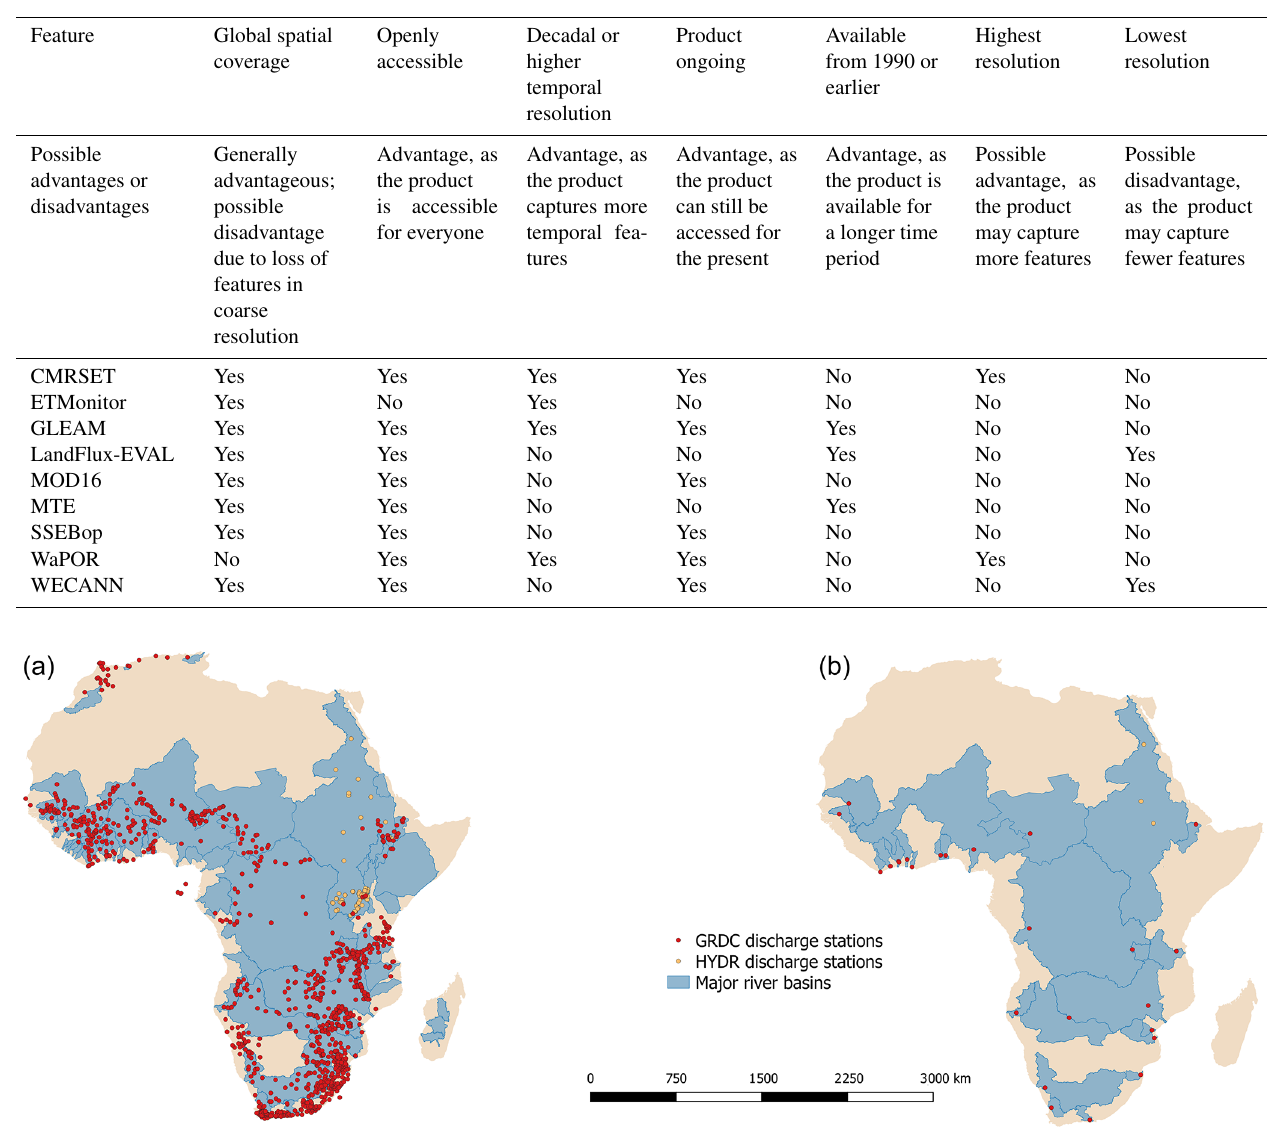
Figure 2. (a) All major basins in Africa and all available discharge stations; (b) major basins in Africa with available discharge data at the